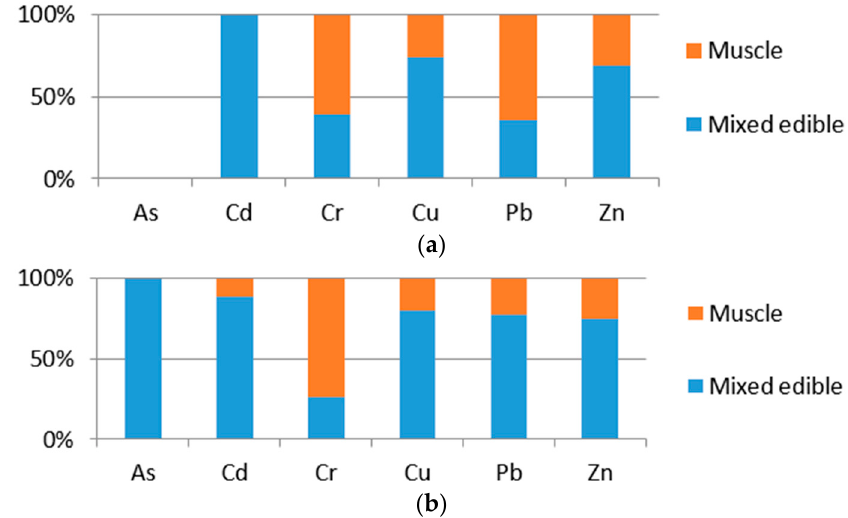
Figure 1. Heavy metals and metalloid concentration (mg/kg wet wt) distribution proportion in muscle and mixed edible tissues of cultured fish ( a ) and wild fish ( b ).